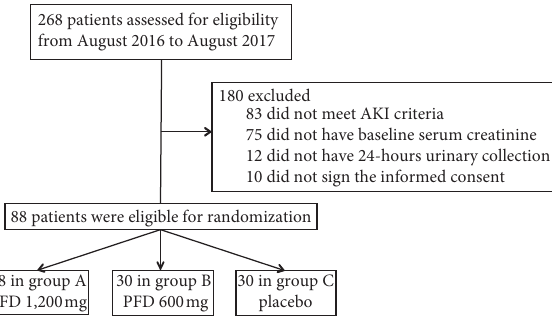
Figure 1: Flowchart of the study Table 1: Demographic and clinical characteristics of patients.